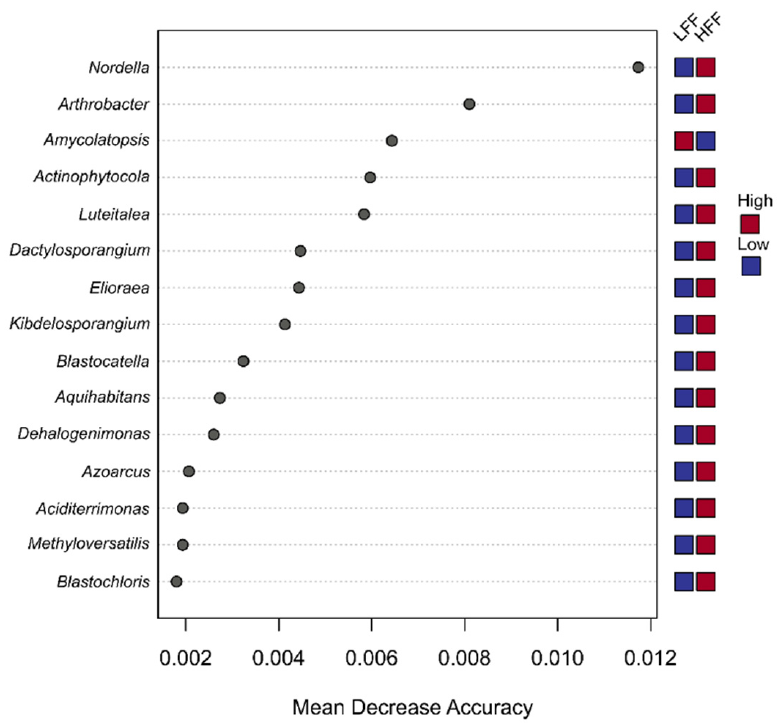
Figure 2. Genus taxonomic rank biomarkers detected in the high fire frequency and low fire frequency sites based on random forest analysis.